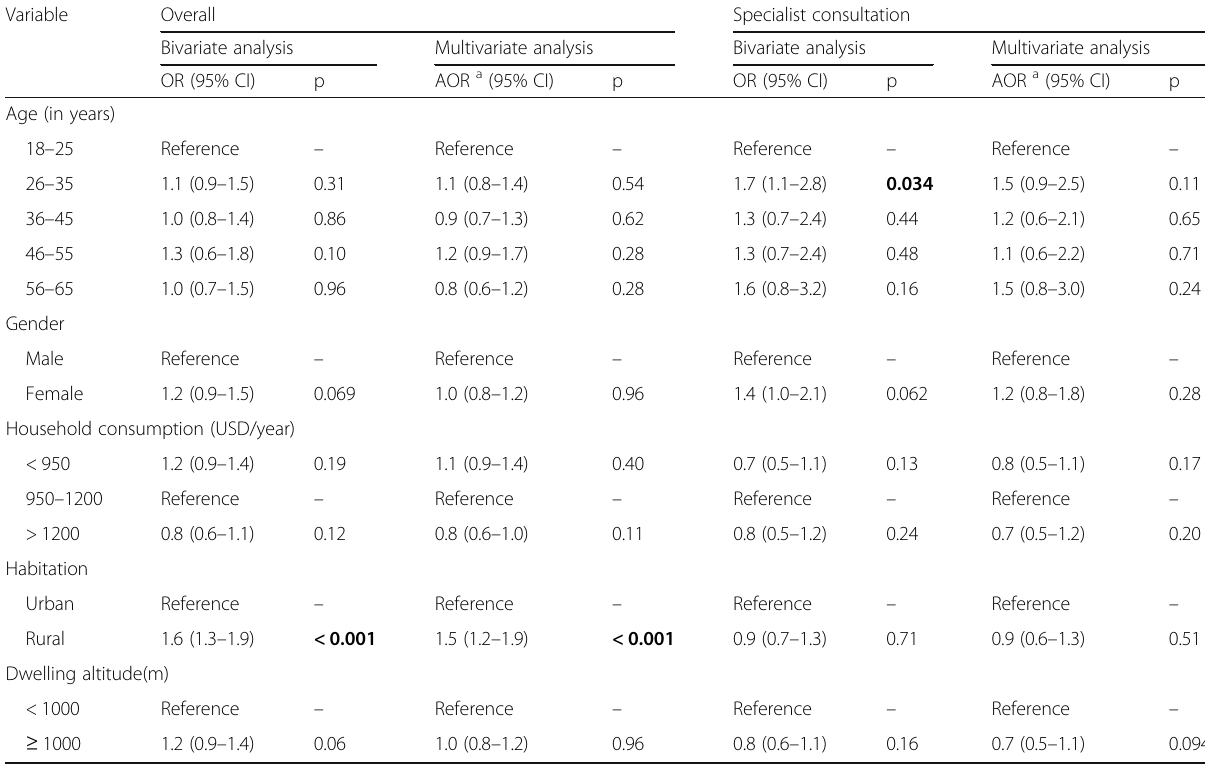
Table 4 Associations between medical consultation and demographic variables Variable Overall Specialist